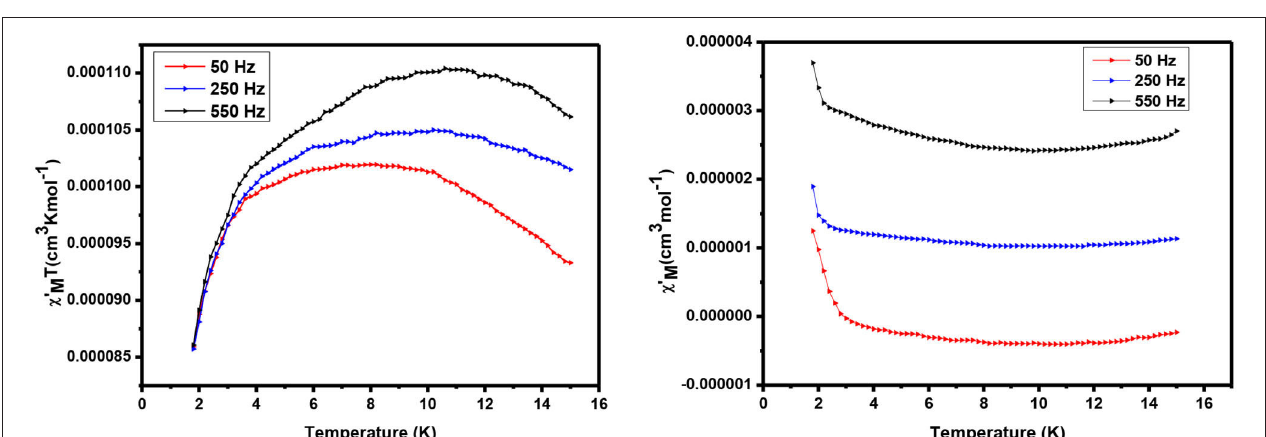
FIGURE 8 | AC susceptibility of complex 2: in phase (Left) and out of phase (Right) .